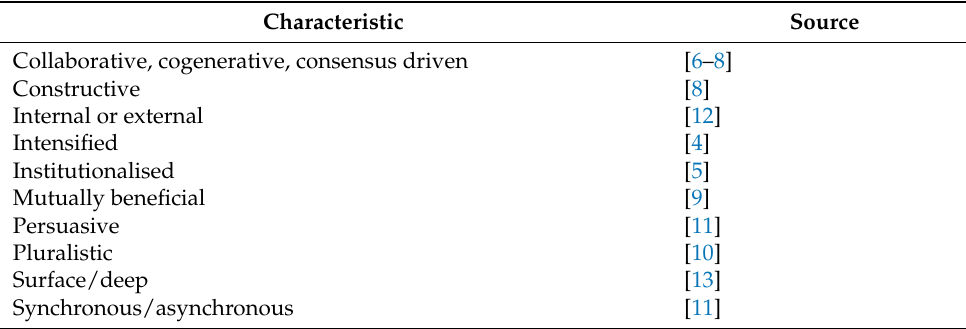
Table 1. Characteristics of dialogues. Characteristic Collaborative, cogenerative, consensus